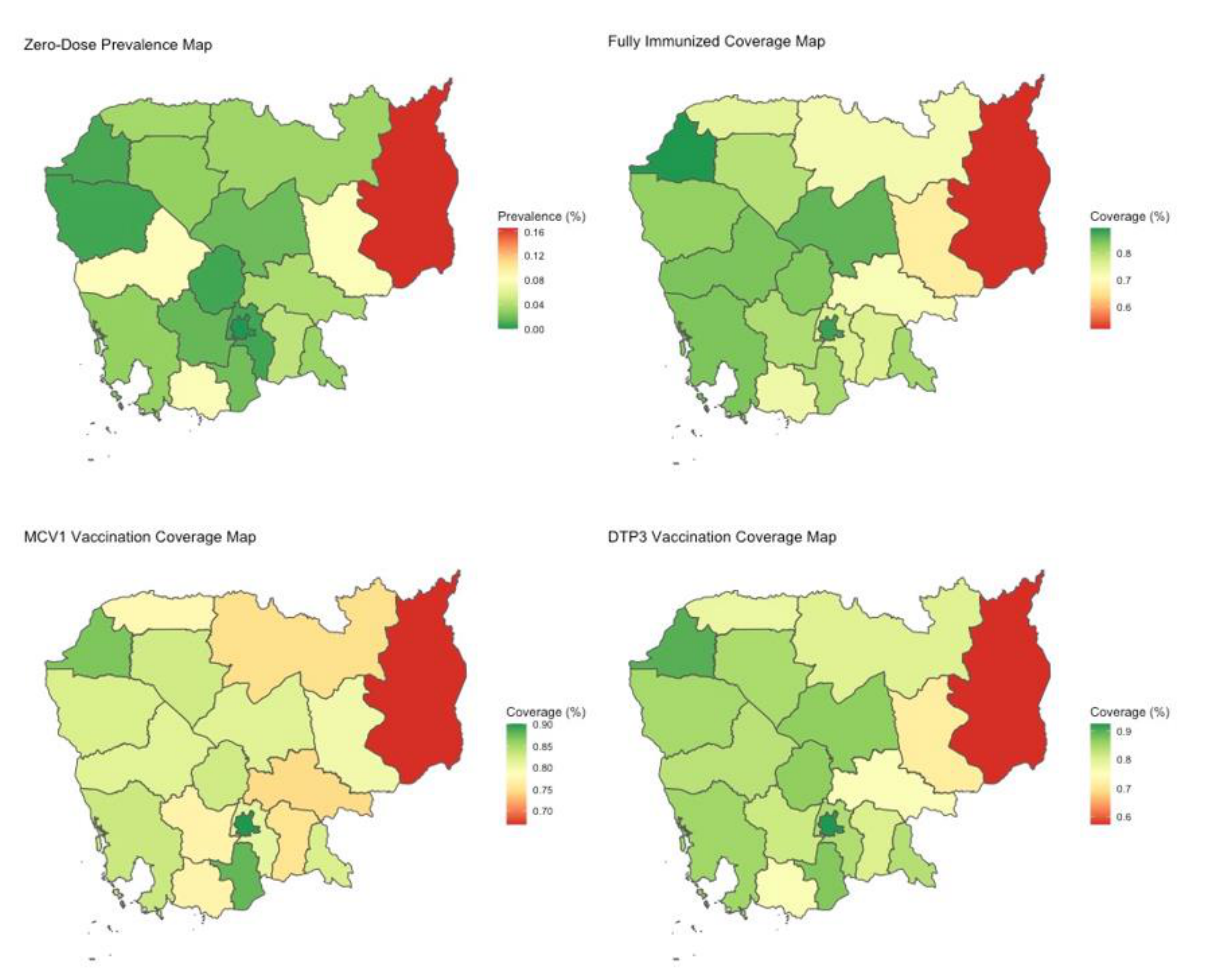
Figure 2. Heat maps portraying coverage/prevalence for ZERO, FULL, MCV1, and DTP3 for survey year 2014. Spatial divides represent individual or pairs of Cambodia’s administrative districts. Table 3. Composite Wagstaff concentration indices for individual districts and district pairs for na- tional immunization program vaccines and vaccination statuses for survey year 2014.